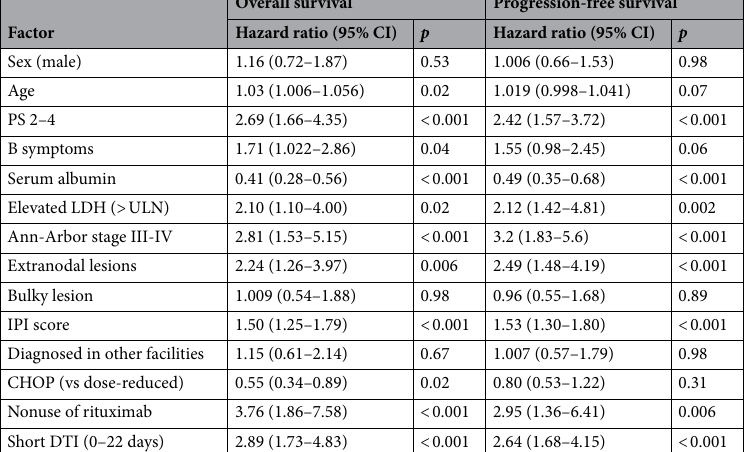
Table 2. Factors associated with survival by univariate analysis. PS performance status, LDH lactate dehydrogenase, ULN upper limit of normal, IPI International Prognostic Index, DTI diagnosis-to-treatment